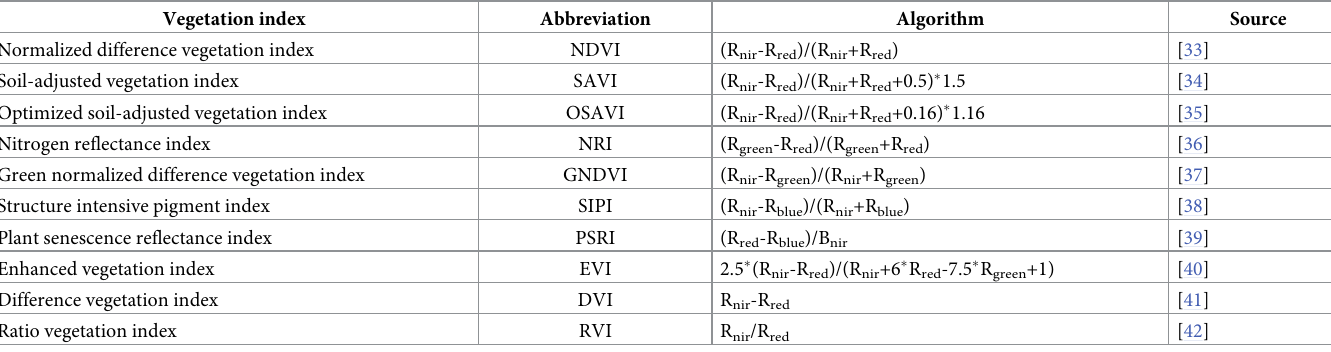
Table 1. Remote sensing vegetation indices used in this